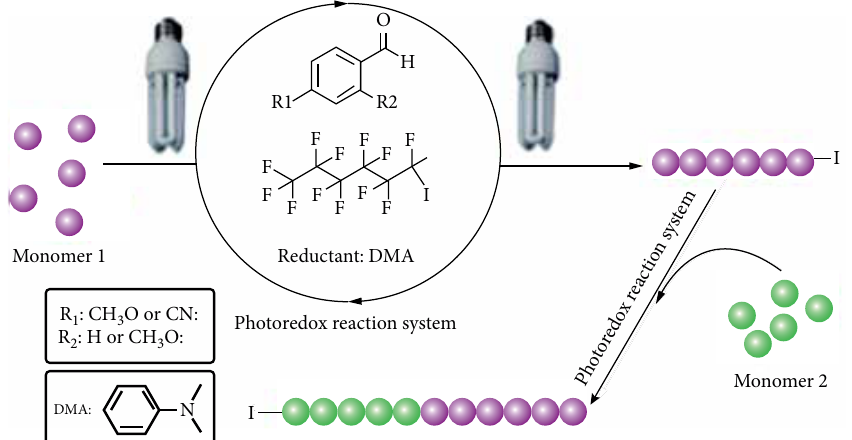
Figure 8: Photoinduced controlled radical polymerization of methacrylates with benzaldehyde derivatives as organic catalysts. (Adapted with permission from Ref.